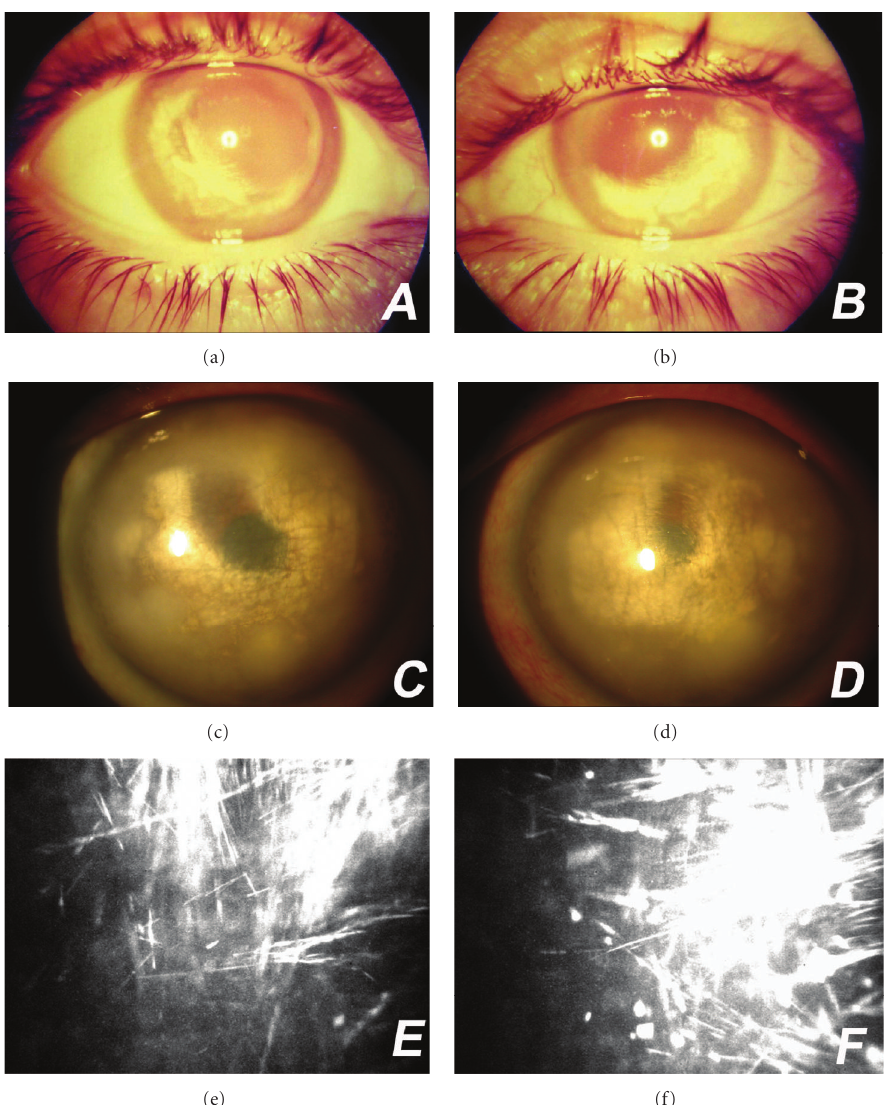
Figure 1: (a and b) Inferior white corneal infiltrates bilaterally in a crescent shape inferotemporally. (c and d) Progression to a complete bilateral annular lipid infiltration in the stroma of both eyes with cholesterol crystals in the paracentral area. (e and f) Confocal microscopy revealed crystalline structures in the stroma